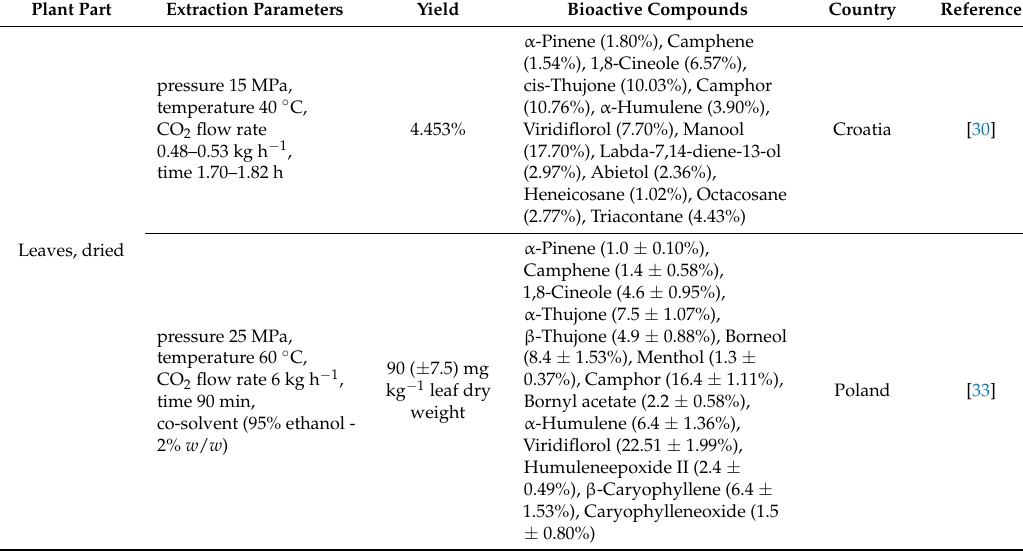
Table 2. The composition of bioactive compounds found in sage extracts obtained by supercritical fluid